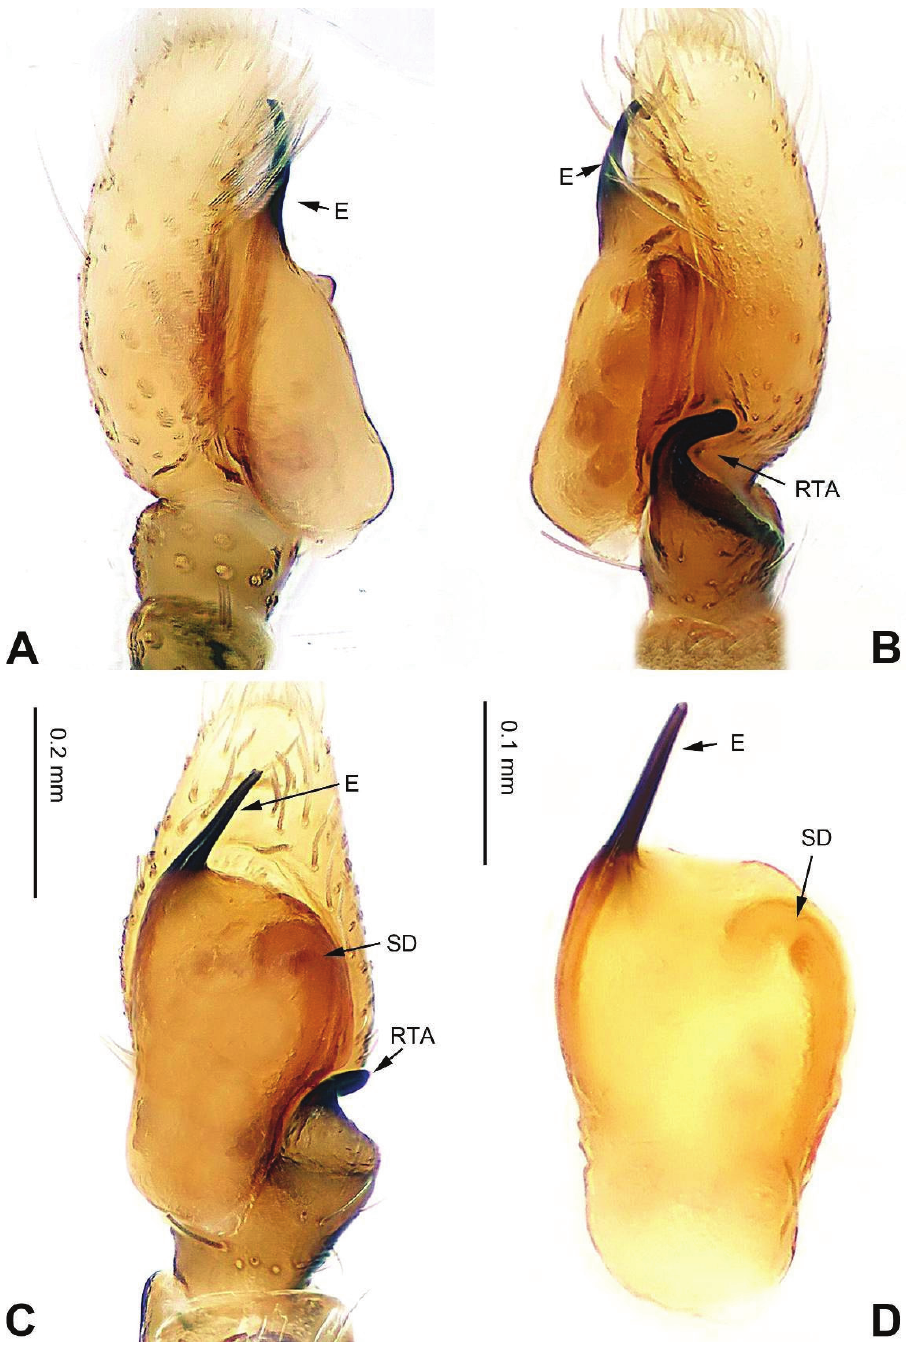
Figure 26. Palp of Icius bamboo sp. n., male holotype. A prolateral B retrolateral C ventral D bulb, ventral. Scale bars: equal for A, B and C